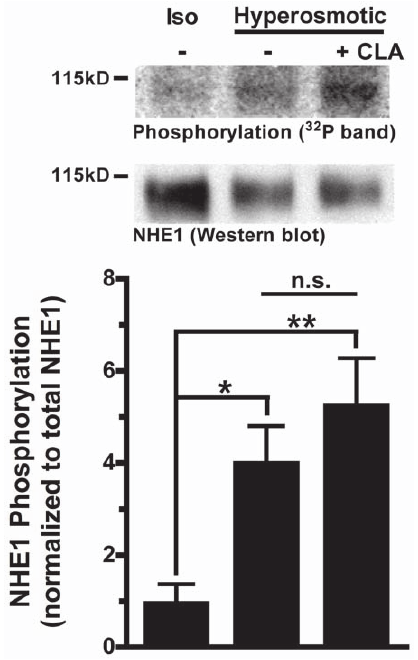
Figure 4. Insitu [ 32 P]-orthophosphate labeling of NHE1 during cell suspension in hyperosmotic medium. (upper) 32 P incorpora- tion into immunoprecipitated NHE1 from at RBCs. autoradiograph images corresponding to immunoprecipitated NHE1 from membrane fractions of [ 32 P]-orthophosphate labeled at RBCs suspended in isosmotic medium, or hyperosmotic media (n1.6 6 IR) with or without CLA treatment. Below each autoradiograph band is the corresponding NHE1 Western blot band detected on the same PVDF membrane. (lower) A quantitative comparison of data from the autoradiograph bands described in panel A (normalized to NHE1 Western blots from the same PVDF membrane). Relative phosphorylation of immunoprecipi- tated NHE1 is significantly increased by suspension of cells in hyperosmotic (n1.6 6 IR) solution with or without CLA treatment relative to the isosmotic control (*p , 0.05 , **p , 0.01; n=6 6 SEM). No significant difference is detected between the two treatment conditions (hyperosmotic 6 CLA;